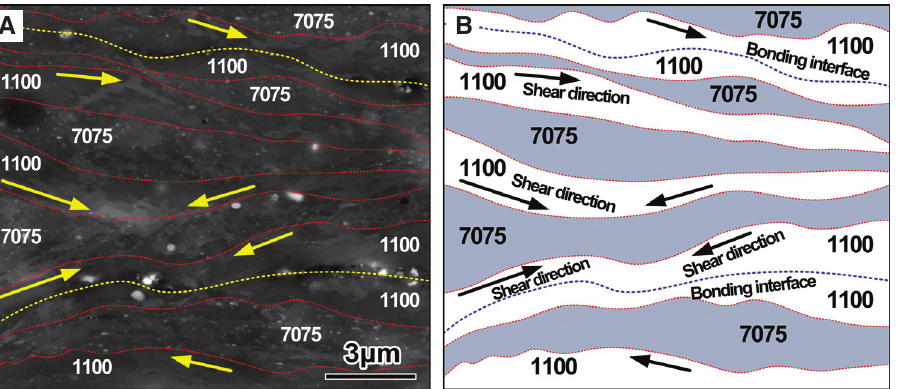
Figure 8 SEM-BSE micrograph on gauge section of the 150 ° C annealed 1280 layer composite sheet after tensile to fracture (corresponding to curve b in Figure 7) showing several shear bands: (A) SEM-BSE magnification showing shear bands; (B) schematic diagram of shear direc- tions at each